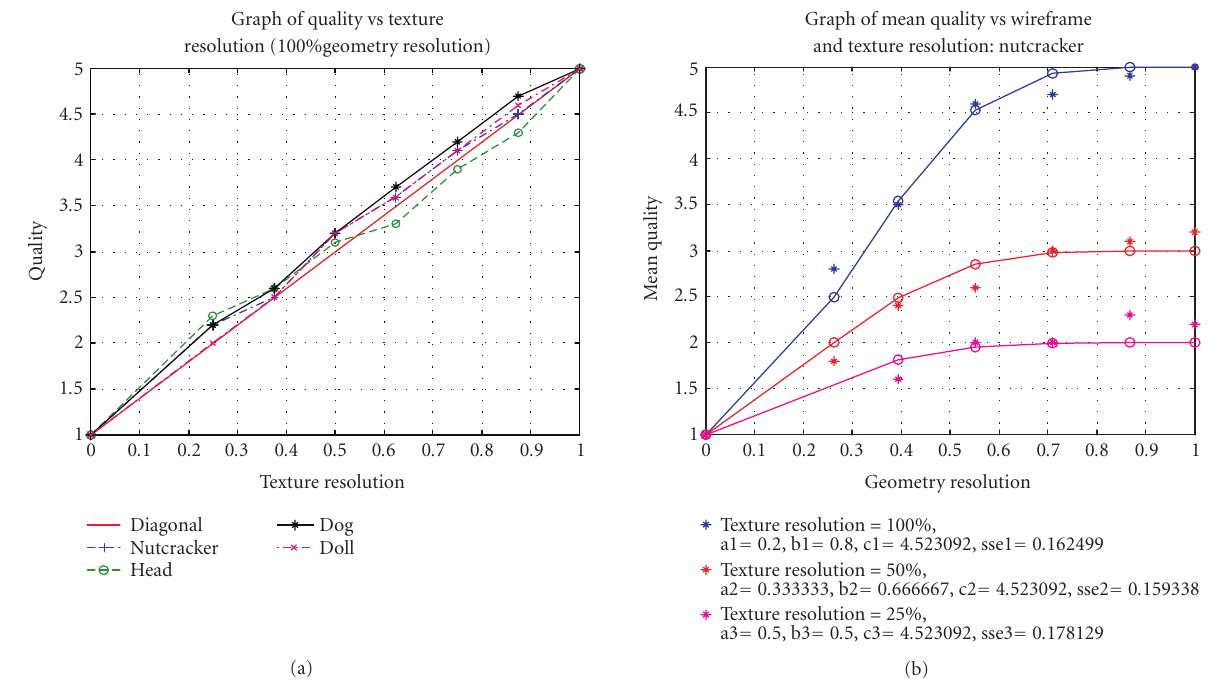
Figure 3: (a): Quality versus texture resolution (100% geometry resolution); (b): quality versus geometry for various texture resolutions.